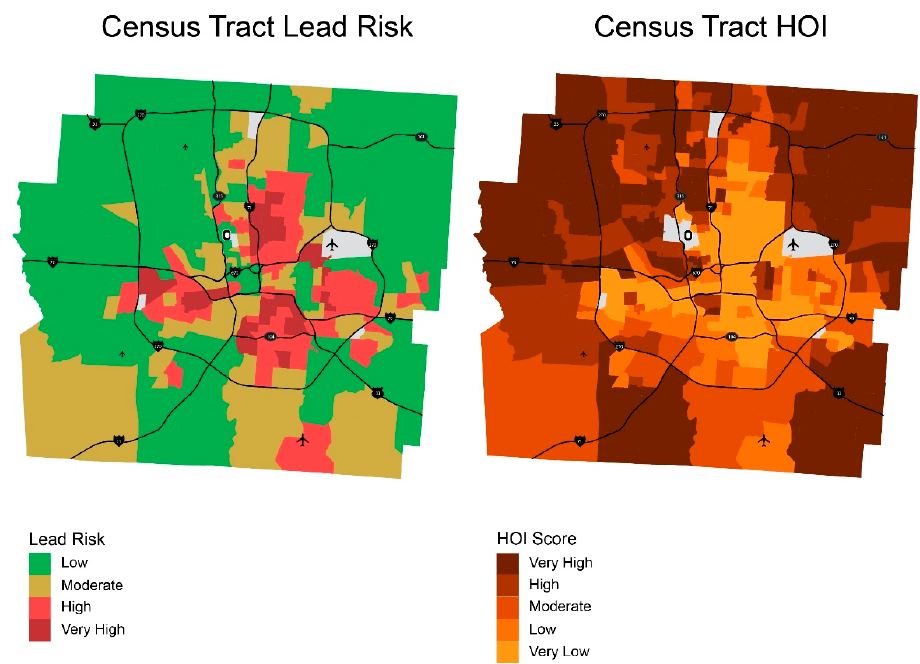
Figure 9. Lead risk versus Health Opportunity Index.